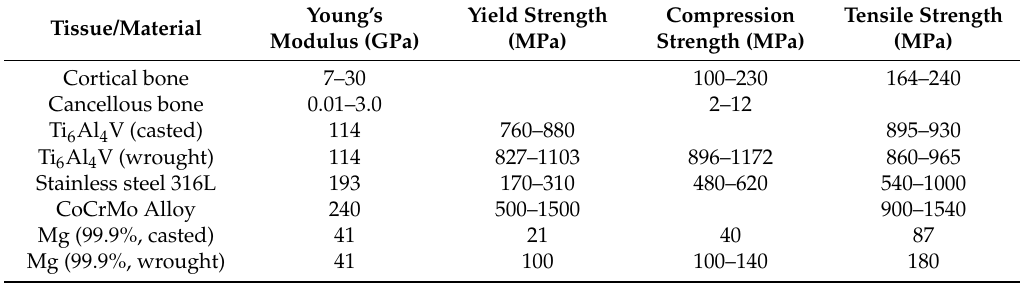
Table 1. A comparison of mechanical properties of metallic implants with bone tissue